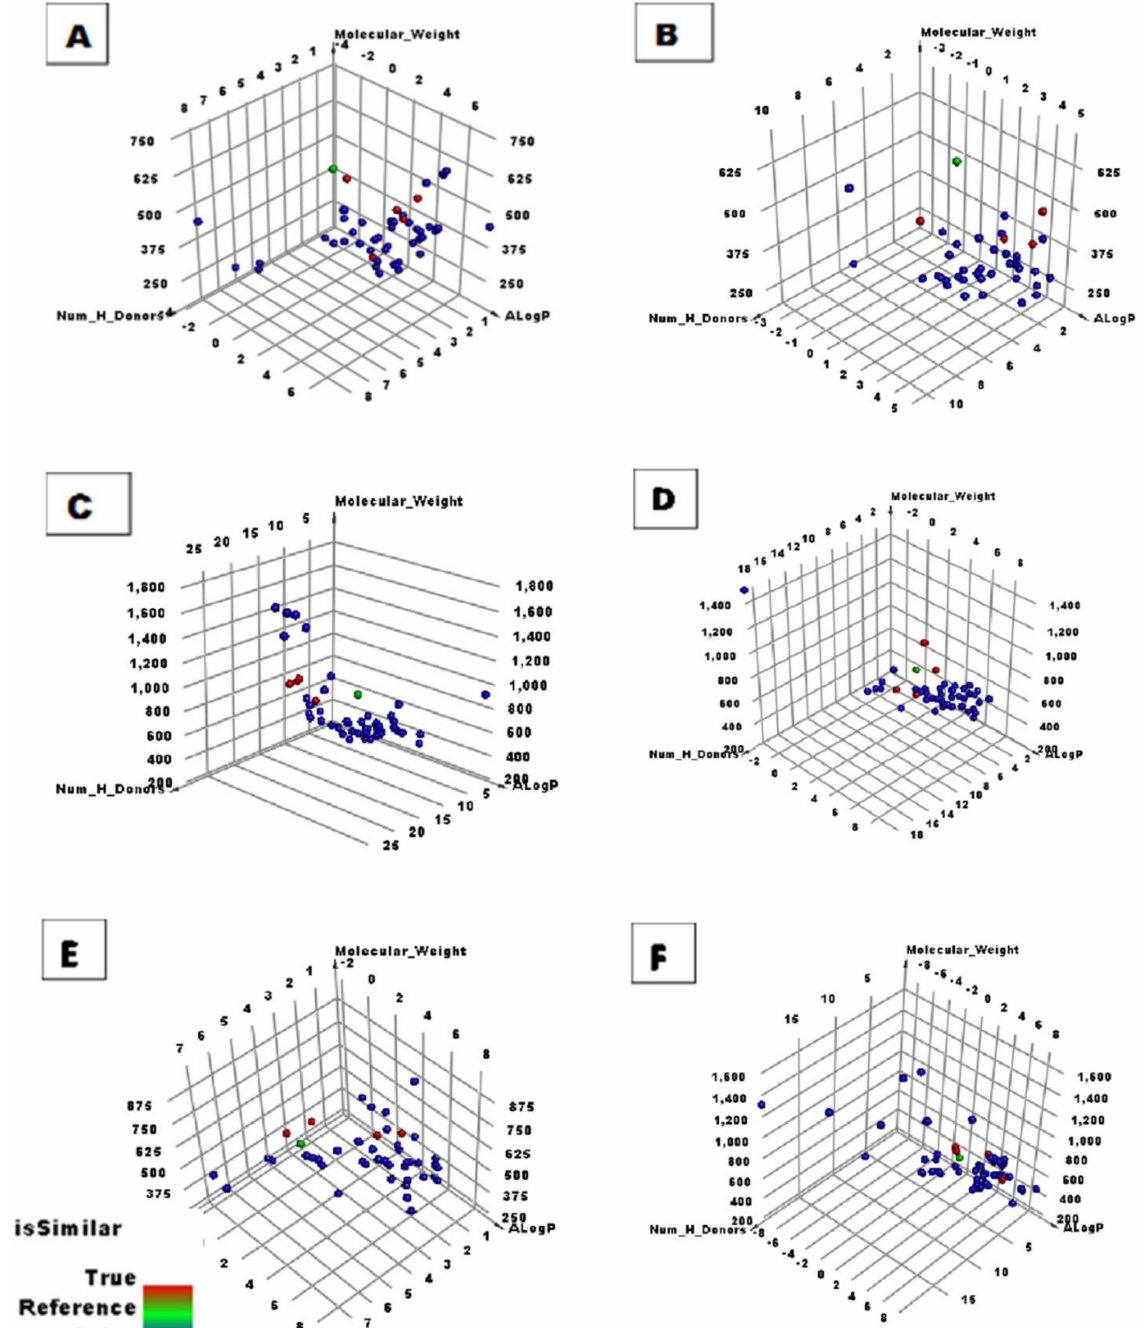
Figure 3. Results of the structural similarity of the antiviral compounds and PRD_002214 . The green sphere is PRD_002214 , the red sphere is a similar compound, and the blue sphere is a dis- similar compound. ( A ) first 50 compounds, ( B ) second 50 compounds, ( C ) third 50 compounds, ( D ) fourth 50 compounds, ( E ) fifth 50 compounds, and ( F ) sixth 60